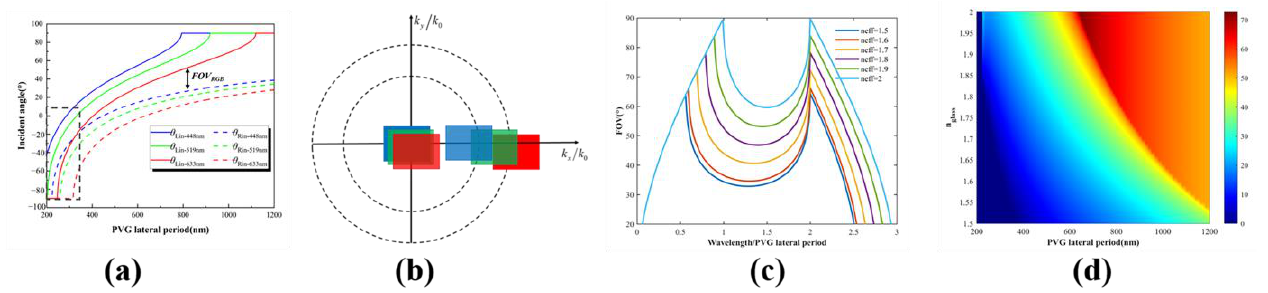
Figure 3. ( a ) Plot of the relationship between Λ x and incident angle ranges at R (633 nm), G (519 nm), and B (448 nm) bands in the single-layer RGB waveguide structure. ( b ) k-vector diagram of the single-layer RGB waveguide. ( c ) Plot of the relationship between λ Λ n ef f values. ( d ) Plot of the relationship between Λ x and FOV with different n ef f values at R (633 nm), G (519 nm), and B (448 nm) bands in the single-layer RGB waveguide structure.